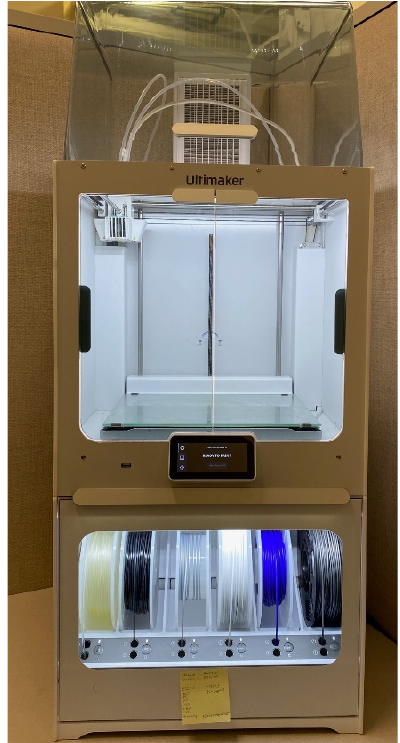
Figure 1. Image of Ultimaker © S5 printer.